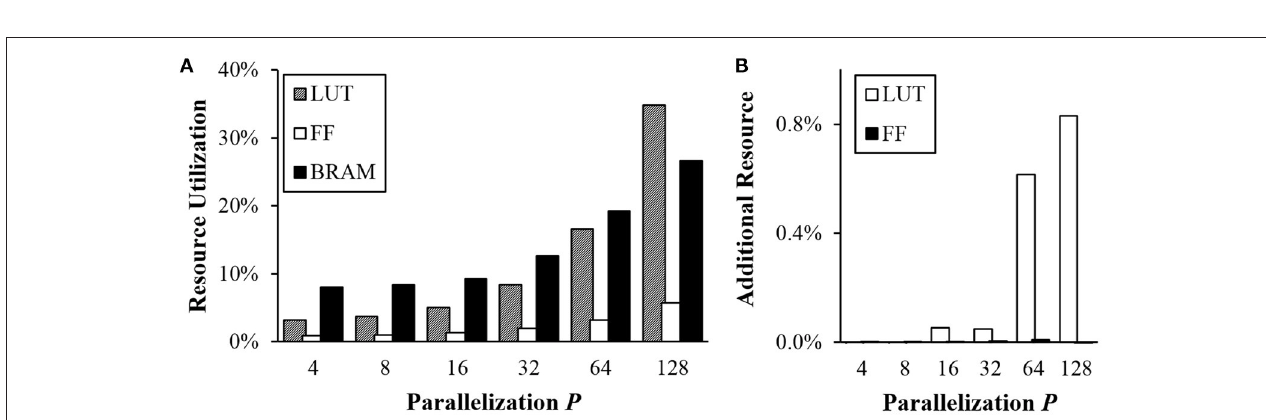
FIGURE 12 | Resource utilization in FPGA (A) vs. P and (B) overhead for the transposable addressing scheme.